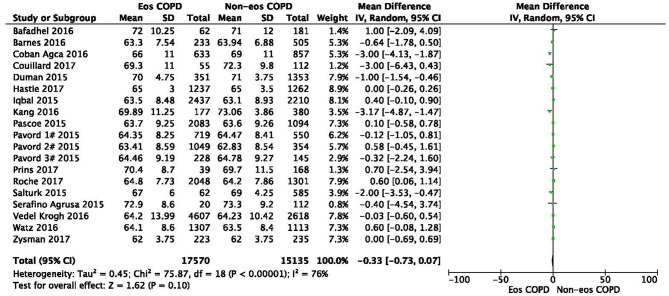
Comparison of age character between eosinophilic and non-eosinophilic COPD. SD, standard derivation; IV, Inverse Variance; CI, confidence interval; Eos, eosinophilic; Non-eos, non-eosinophilic; COPD, chronic obstructive pulmonary disease.